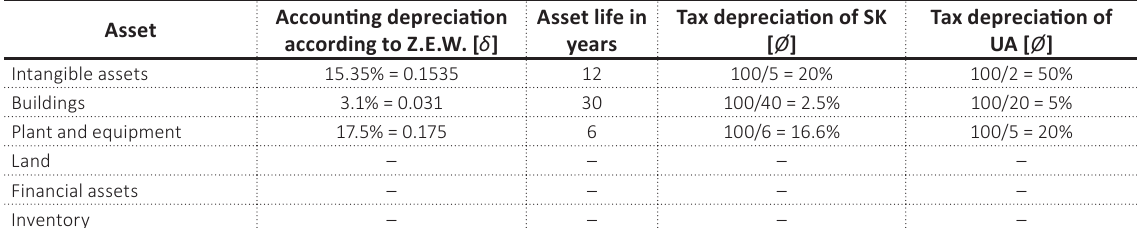
Table 1. Input assets for Slovakia (SK) and Ukraine